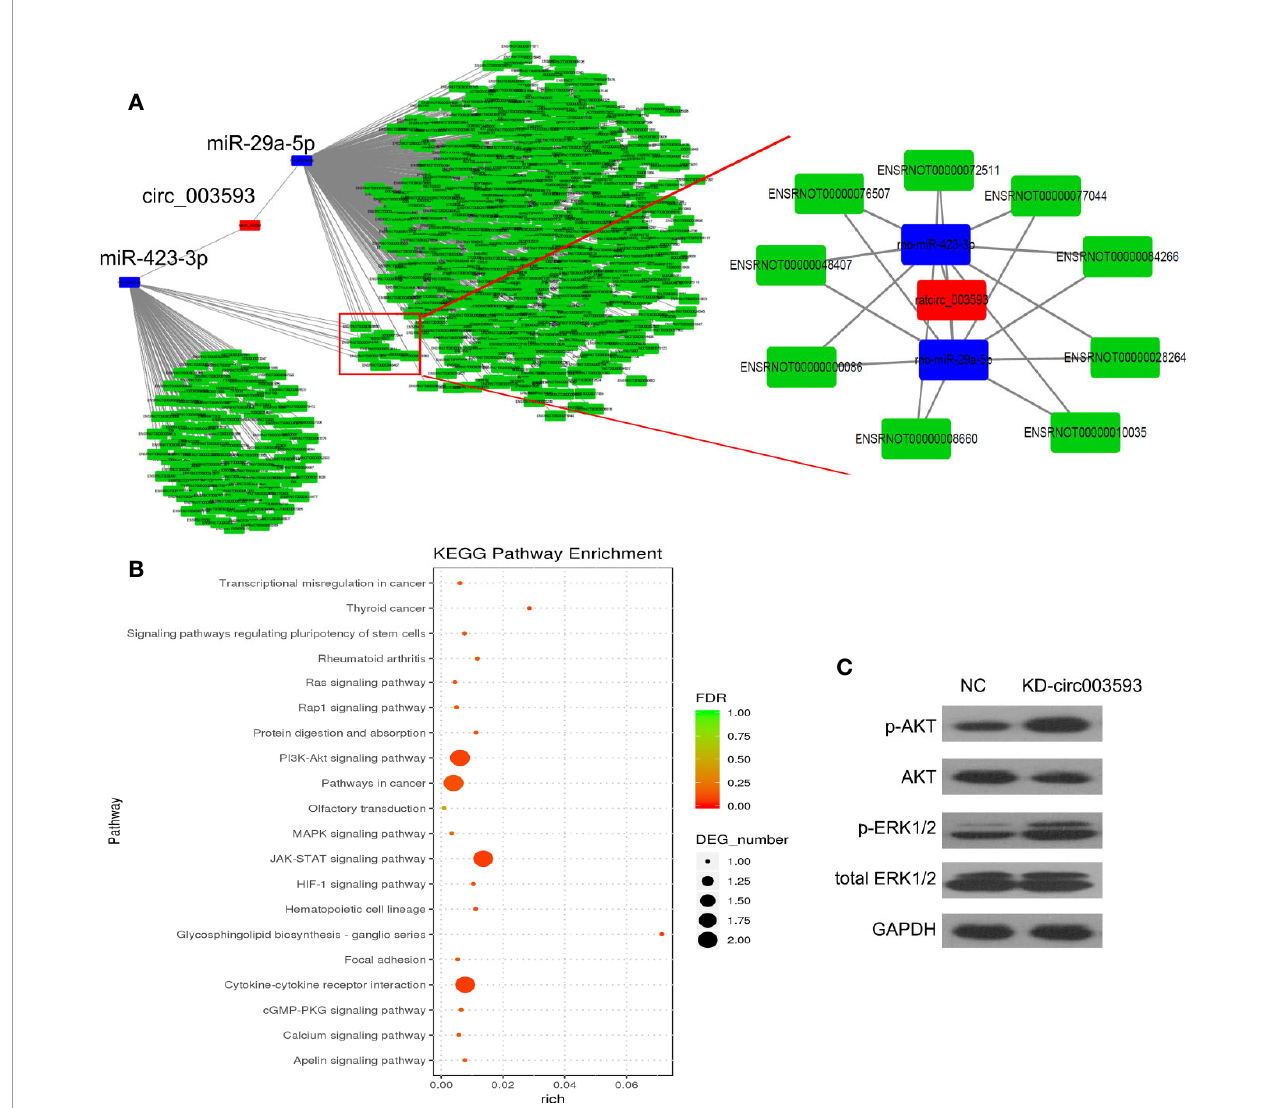
FIGURE 6 | The downstream targets and pathways of circ_003593. (A) The predicted miRNA and mRNA targets of circ_003593. (B) KEGG pathway enrichment involved in circ_003593. (C) Western blot was performed to determine the expression of AKT and ERK1/2 in H9c2 cells after circ_003593 knockdown. KD,